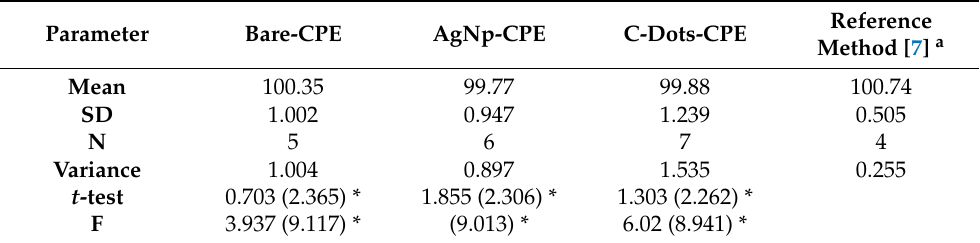
Table 5. Statistical comparison between the proposed methods and the reference method [7] of TOBRA in its pure